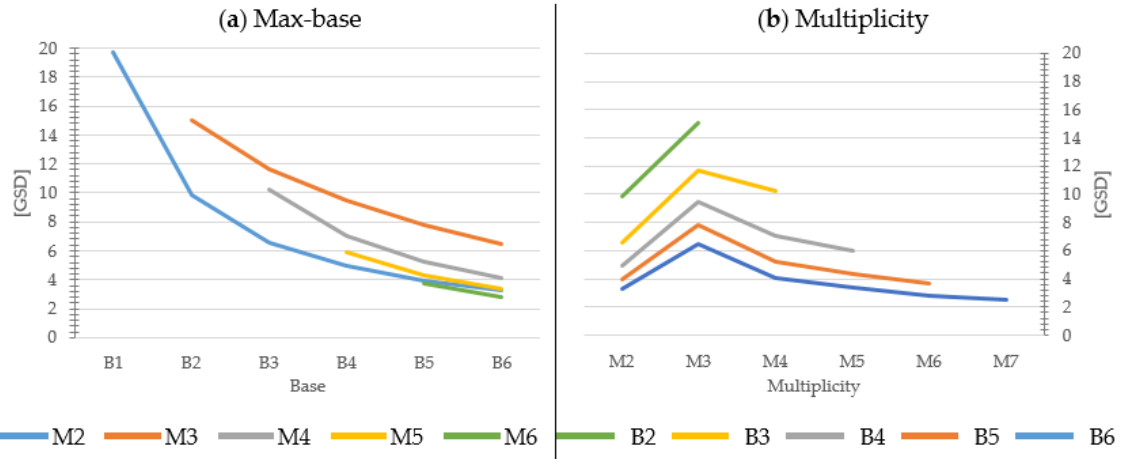
Figure 14. Graphs showing the standard deviation of errors on the Z coordinate obtained as a result of the Monte Carlo simulation: ( a ) influence of max-base and ( b ) influence of multiplicity.